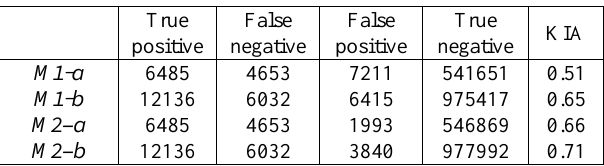
Table 3. Pixel based evaluation of change detection results for the two test sites.